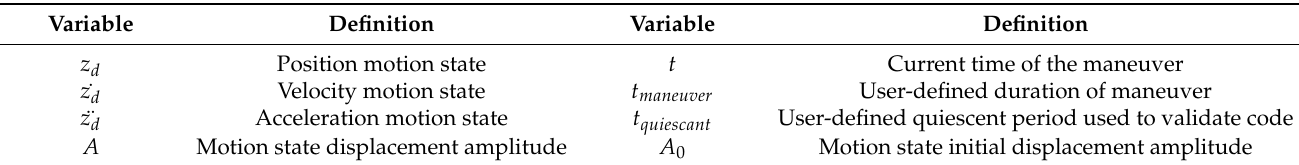
Table 2. Sinusoidal Trajectory Variable